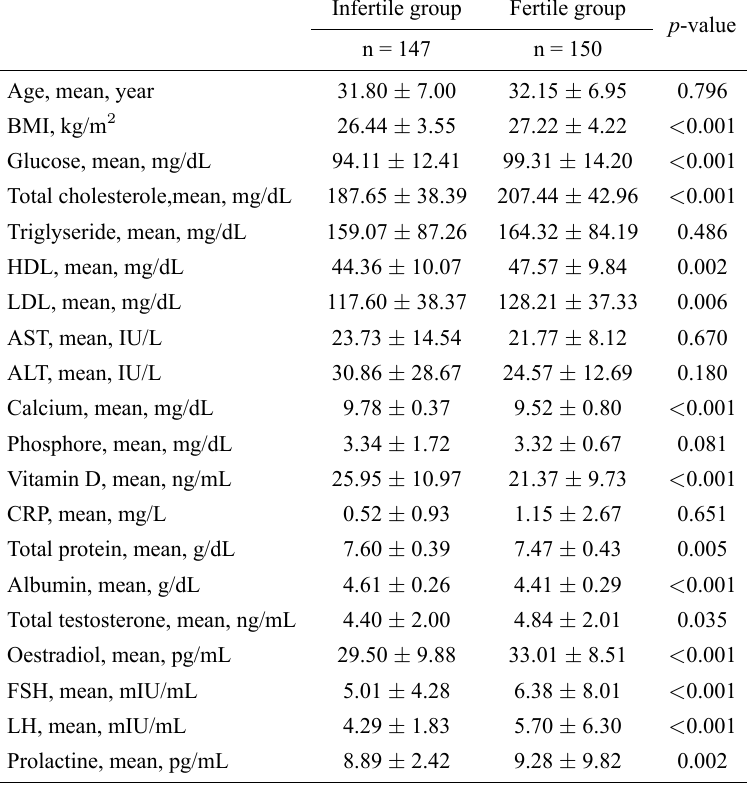
Table 1. Patient demographic and laboratory characteristics according to the groups.